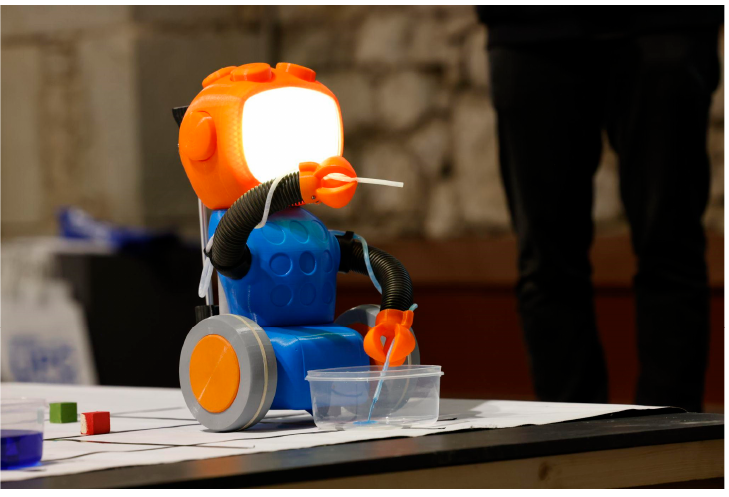
Figure 12. The 3D Qui-Bot, the programming blocks (green and blue) and the robot emptying blue liquid [33].